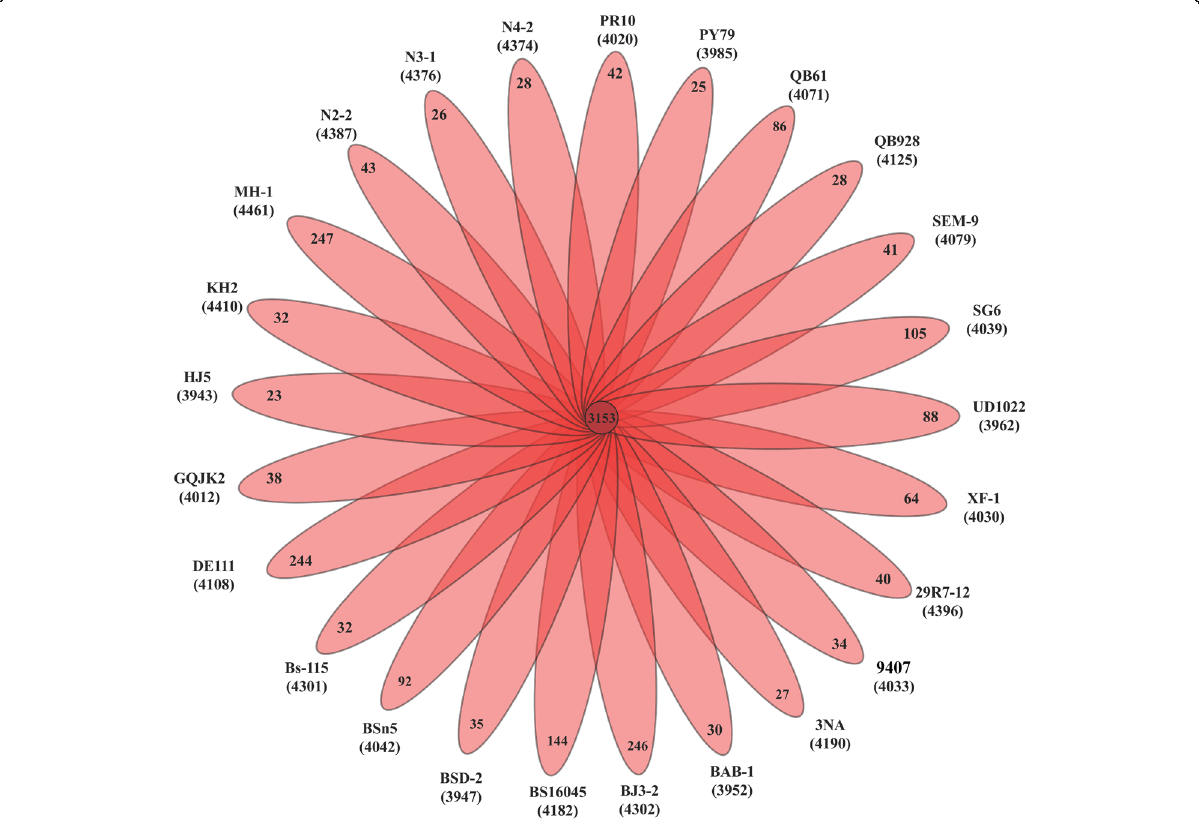
Fig. 3 Pan-genome analysis of B. subtilis 9407 and 24 other B. subtilis strains. Flower plot showing numbers of species-specific genes commonly found in each genome of each species (in the petals), and B. subtilis core orthologous gene number (in the center)